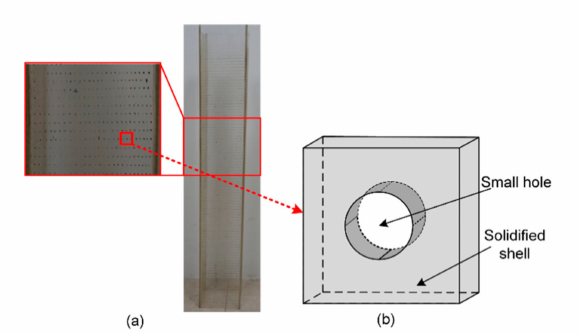
Figure 3. The sketch diagram of the arrangement of small holes on the solidified shell: ( a ) photograph; ( b ) view of single